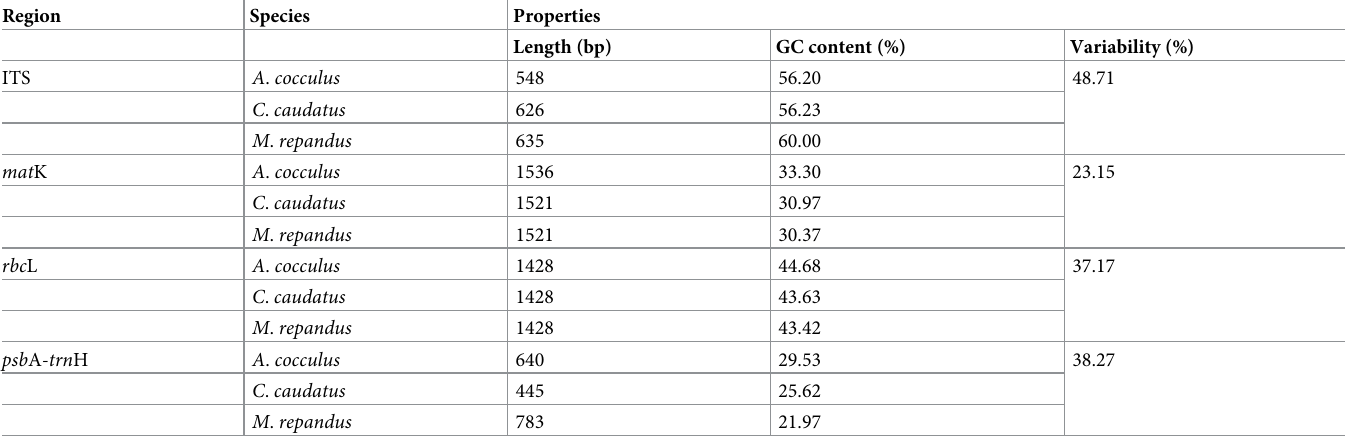
Table 3. Sequence analysis of core DNA barcode regions of A . cocculus , C . caudatus and M . repandus .